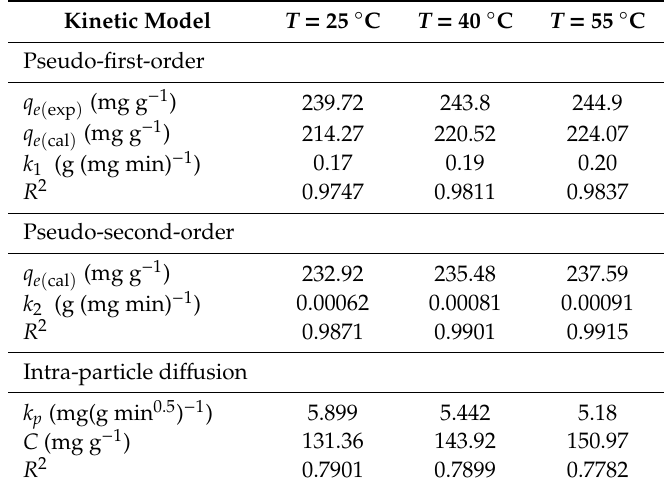
Table 3. Parameters of kinetic models for the adsorption of CV on MNP/CTAB-EC composite. Kinetic Model